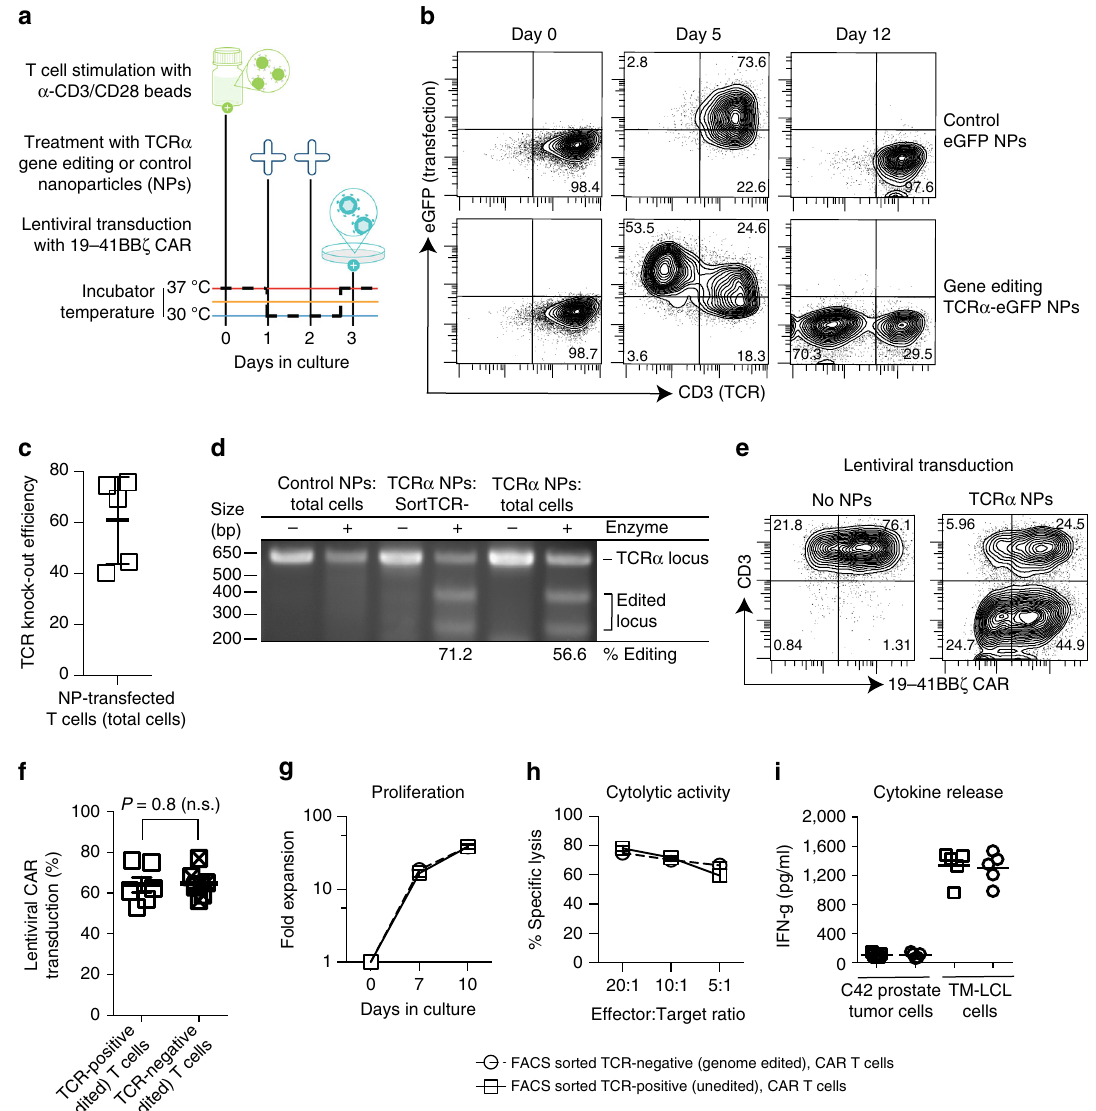
Fig. 3 Nanoparticles can knockout T cell receptors in CAR-programmed lymphocytes. a Integration of nanoparticle (NP) transfection into normal manufacturing of CAR-T-cells. After stimulation with anti-CD3/CD28-coated beads (day 0), CD8-targeted mRNA NPs were introduced on days 1 and 2, then lentiviral transduction with a vector encoding the leukemia-speci fi c 19-41BBz CAR was performed on day 3. We added either NPs carrying mRNAs encoding megaTAL nuclease plus eGFP, or control particles loaded with eGFP mRNA alone. b Flow cytometry of NP transfection ef fi ciencies (based on eGFP signals) correlated with surface expression levels of TCRs (based on CD3 signals) by T-cells following NP treatments. c Summary plot showing editing ef fi ciency as measured by loss of CD3 surface expression at day 14 ( n = 6). d Surveyor assay con fi rming TCR α chain gene locus disruption. e Flow cytometry of lentiviral transduction in genome-edited versus control T-cells. f Bar graph showing mean viral transductions and SE of three independent experiments conducted in duplicate; n.s., not signi fi cant g , h Proliferation and cytolytic activity of TCR+ (FACS sorted TCR-positive, unedited 19-41BBz CAR-T-cells) and TCR- (FACS sorted TCR-negative, genome edited) 19-41BBz CAR-T-cells. To measure proliferation, T-cells were co-cultured on irradiated TM-LCL leukemia cells. Cytolytic assays were performed with CD19-expressing K562 target cells. i T cell IFN- γ release was measured with